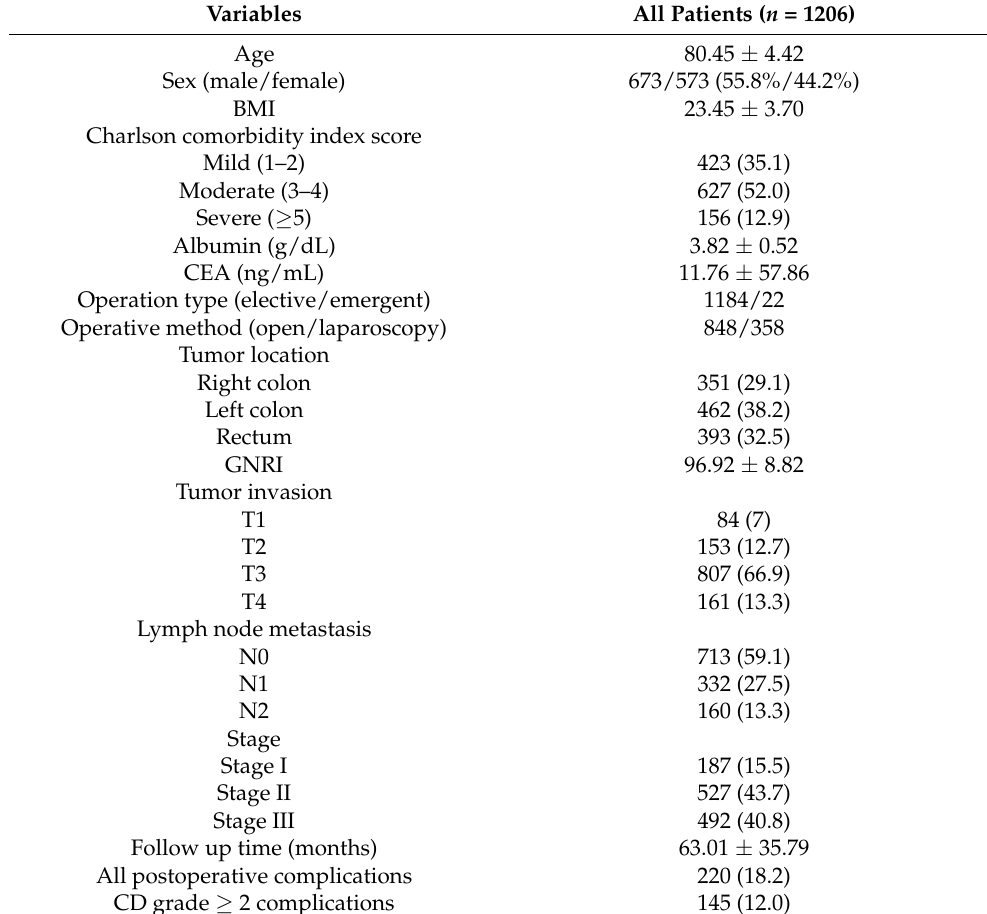
Table 1. Demographic characteristics of 1206 patients undergoing radical resection for stage I–III